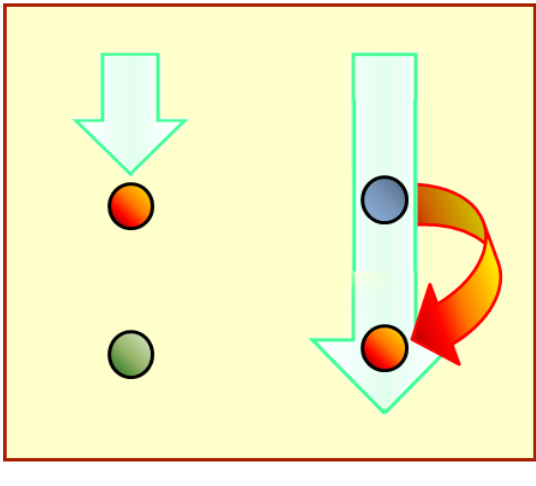
Figure 7. In optimum configurations, off-resonant laser light can enhance or trigger RET. An initially excited chromophore (red dot) transfers energy to its acceptor neighbour beneath only when an off-resonant beam (right) passes through the